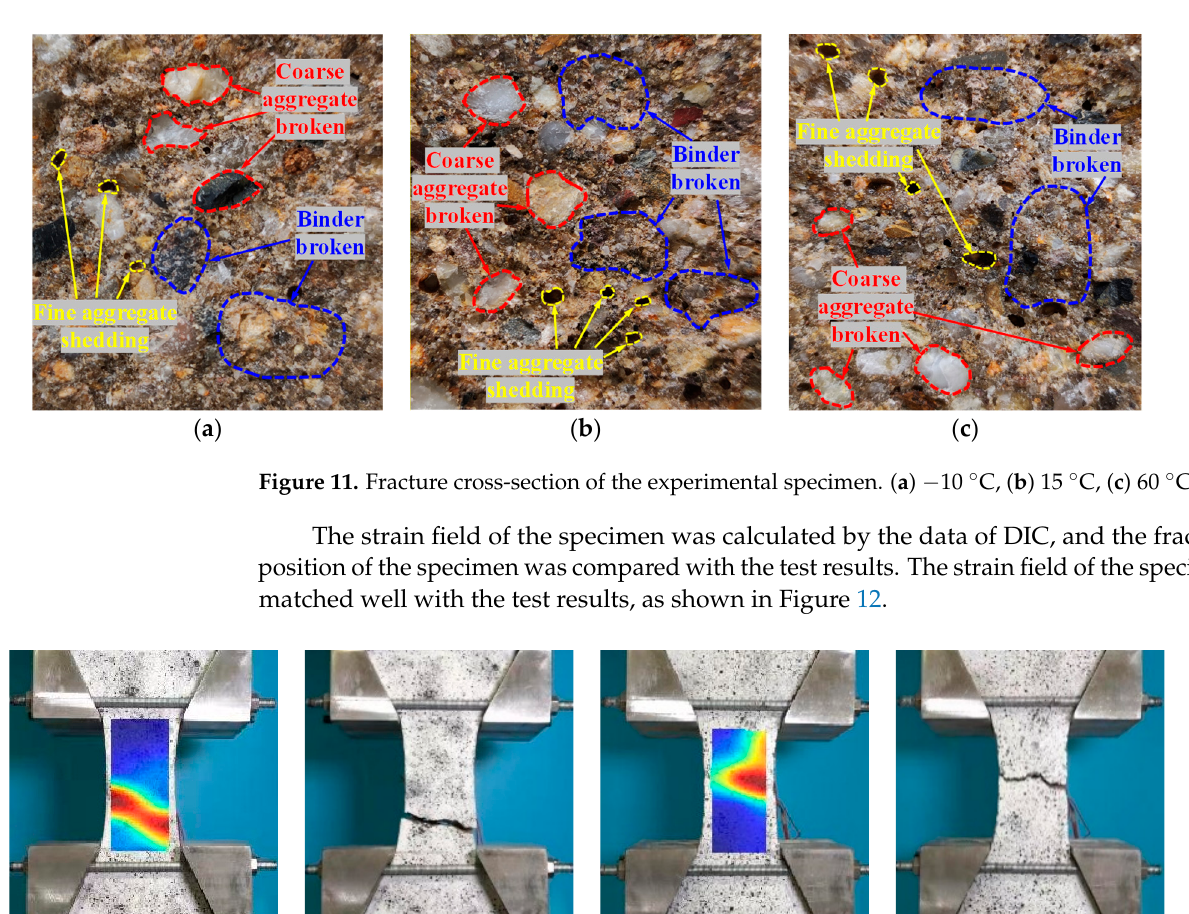
Figure 10. Schematic diagram of fracture section of specimen.